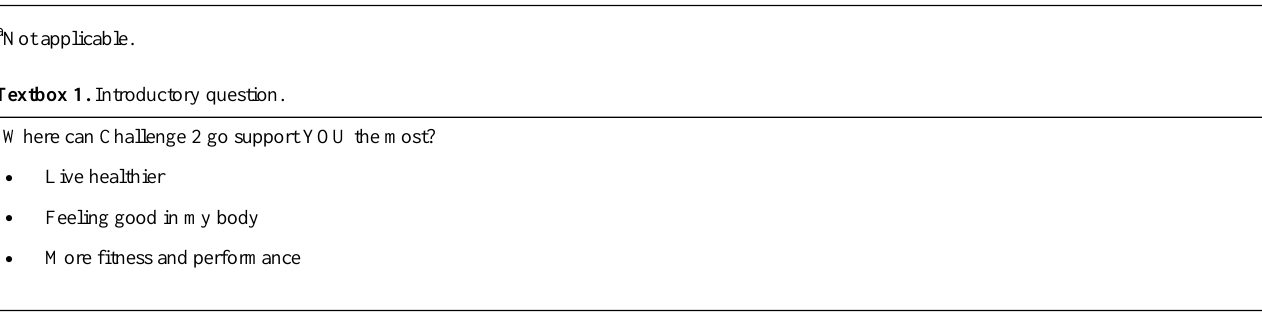
Prototype IIPrototype IApp